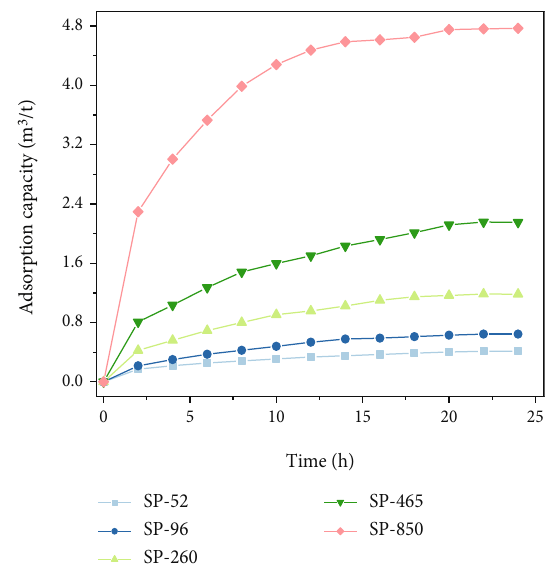
Figure 3: Variation curve of amount of H di ff erent concentrations of H